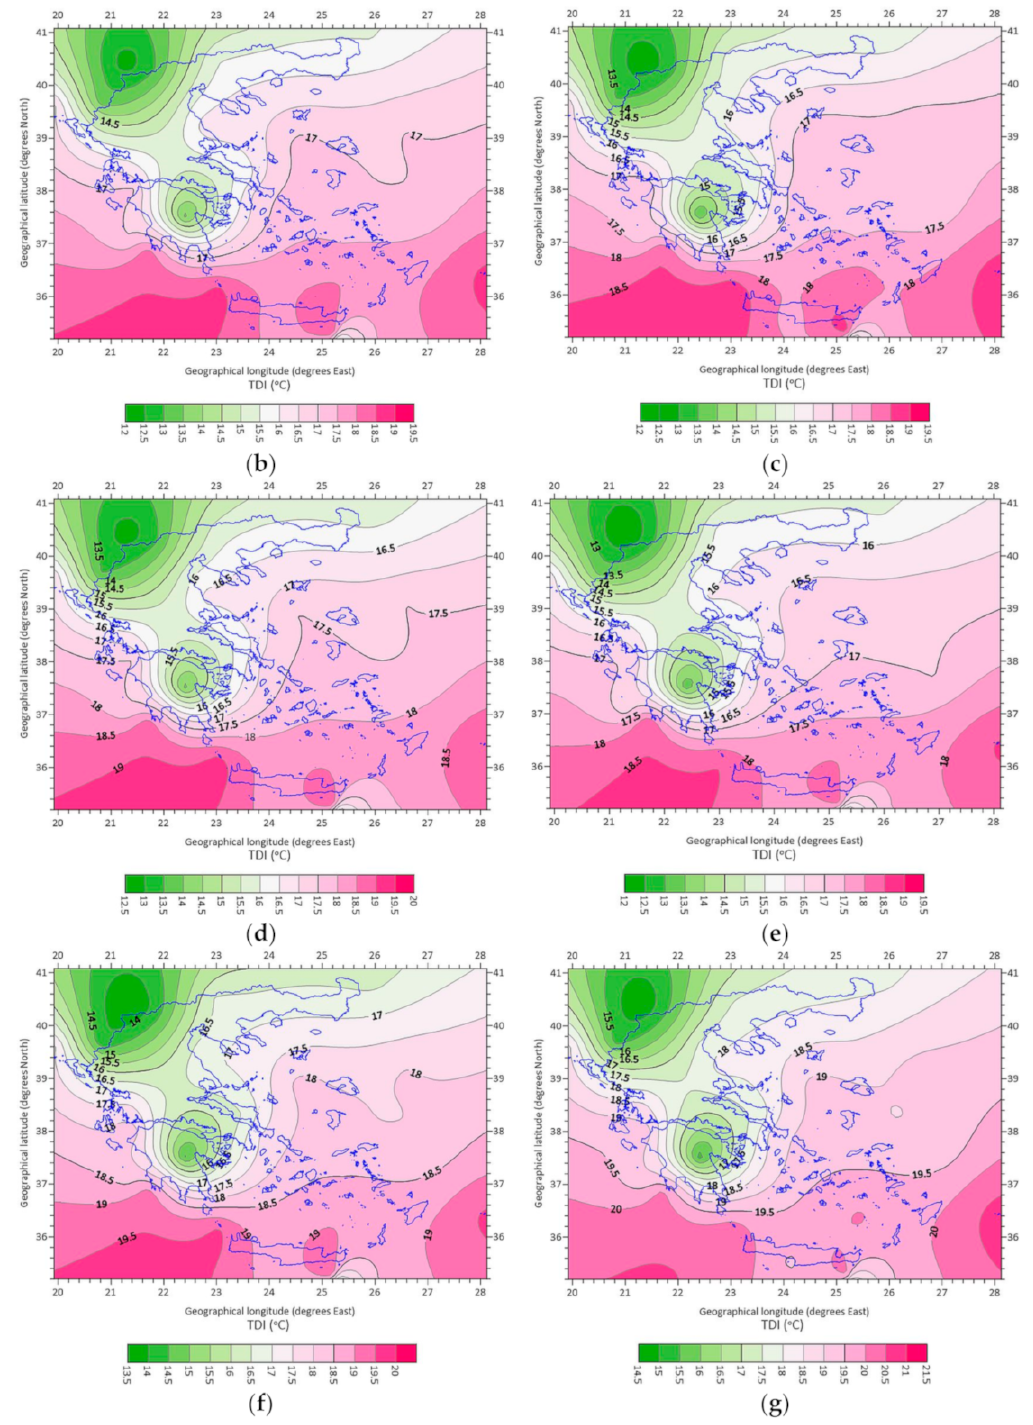
Figure 9. Distribution of annual mean TDI values (in ◦ C) across Greece for the various epochs studied: ( a ) historical 1985– 2014, ( b ) RCP 4.5 2021–2050, ( c ) RCP 4.5 2046–2075, ( d ) RCP 4.5 2071–2100, ( e ) RCP 8.5 2021–2050, ( f ) RCP 8.5 2046–2075, and ( g ) RCP 8.5